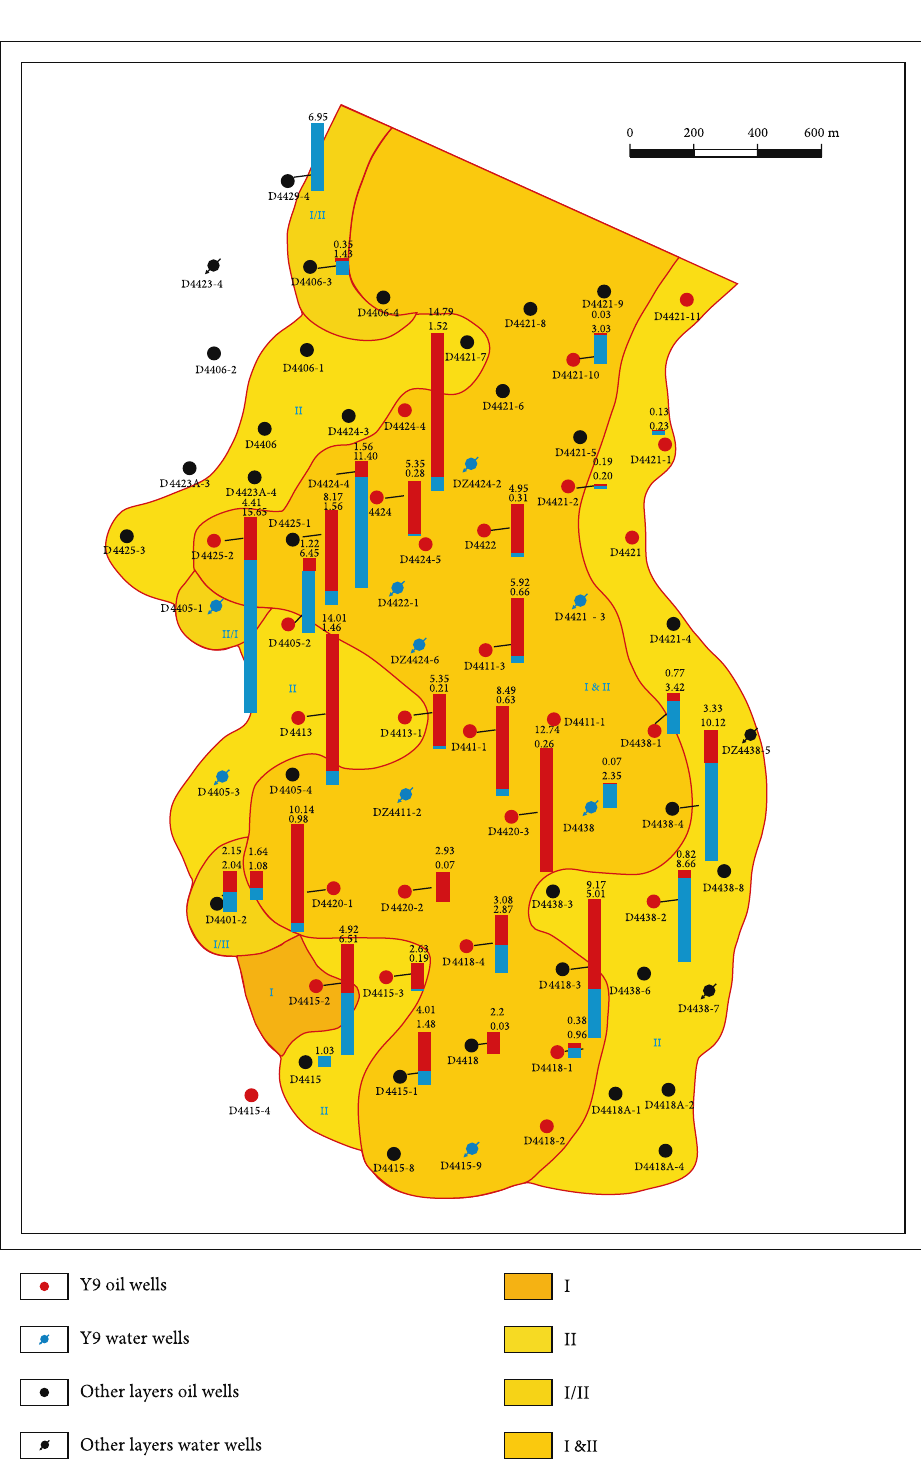
Figure 13: Plane distribution of sand body con fi guration of the Yan 9 32